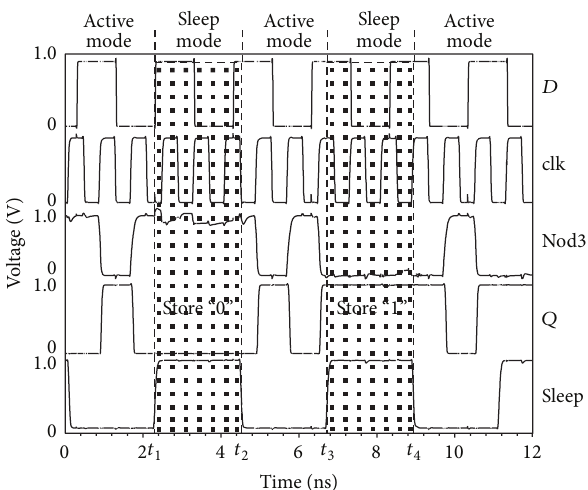
Figure 9: The simulation waveform of the ADR-FF.